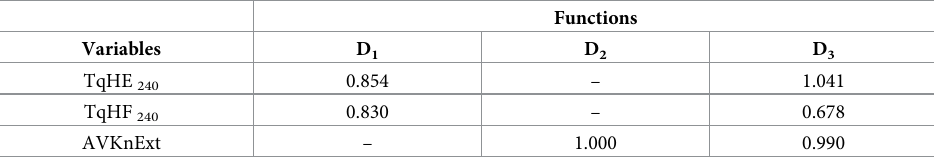
Table 5. Standardized canonical function